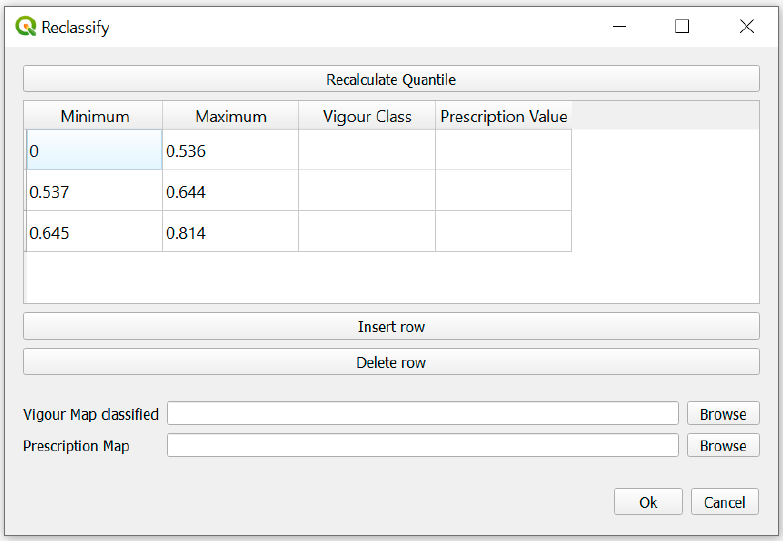
Figure 4. Reclassification window of the QVigourMaps graphical user interface.